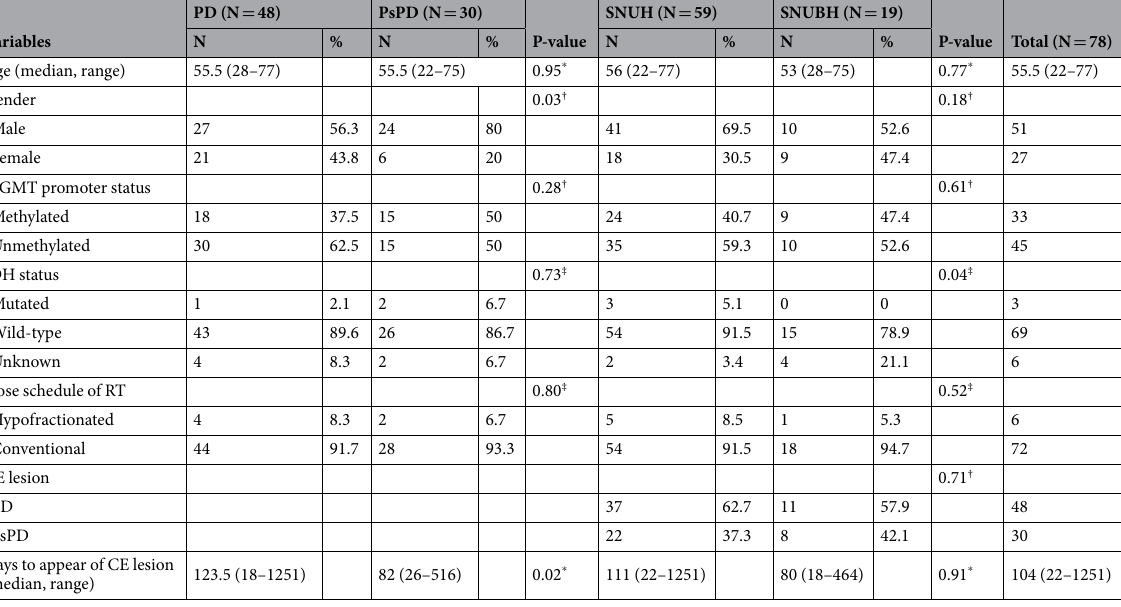
Table 1. Patient Characteristics. * Student’s T-test, † Chi-squared test, ‡ Fisher’s exact test. Abbreviations: PD, progressive disease; PsPD, pseudoprogression; MGMT, O6-methylguanine-DNA-methyltransferase; IDH, isocitrate dehydrogenase; CE, contrast enhancement; RT, radiation therapy; SNUH, Seoul National